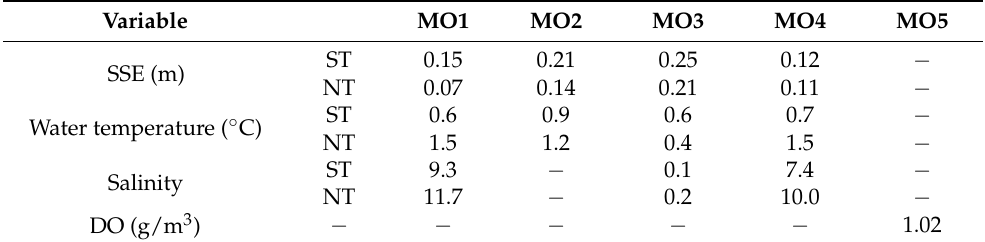
Table 3. RMSE for Mondego estuary (MO1, MO2, MO3, MO4, MO5 stations); ST—spring tide; NT—neap